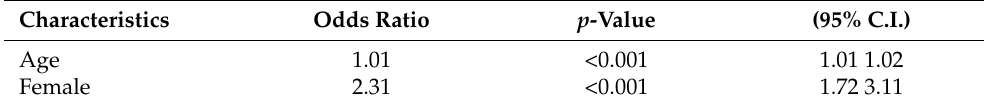
Table 4. Multivariate logistic regression for asymptomatic